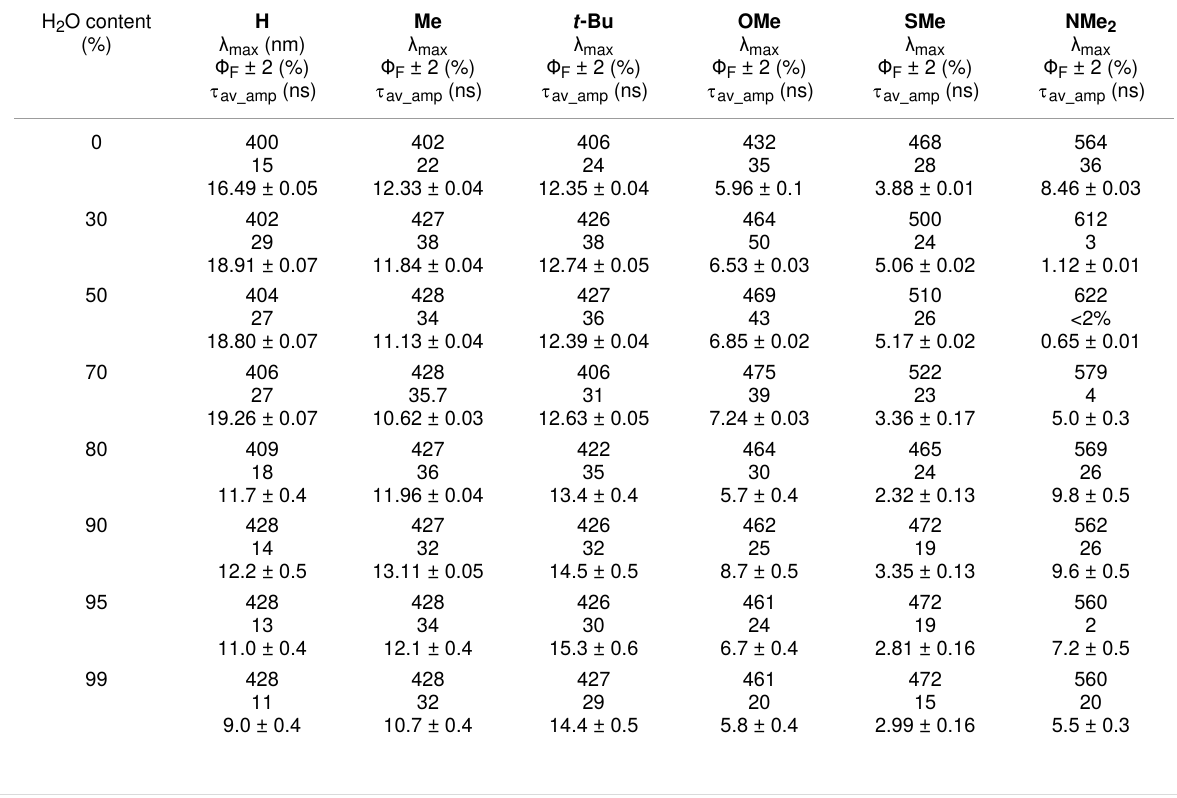
Table 2: Emission maxima, Φ F and for each fraction of water. av_amp : average lifetimes (amplitude weighted).